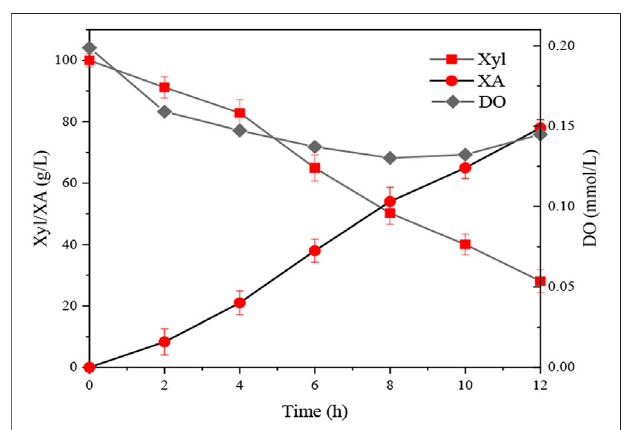
FIGURE 4 | XA production under the optimized conditions. Xyl (cid:2) xylose; XA (cid:2) xylonic acid; DO (cid:2) dissolved